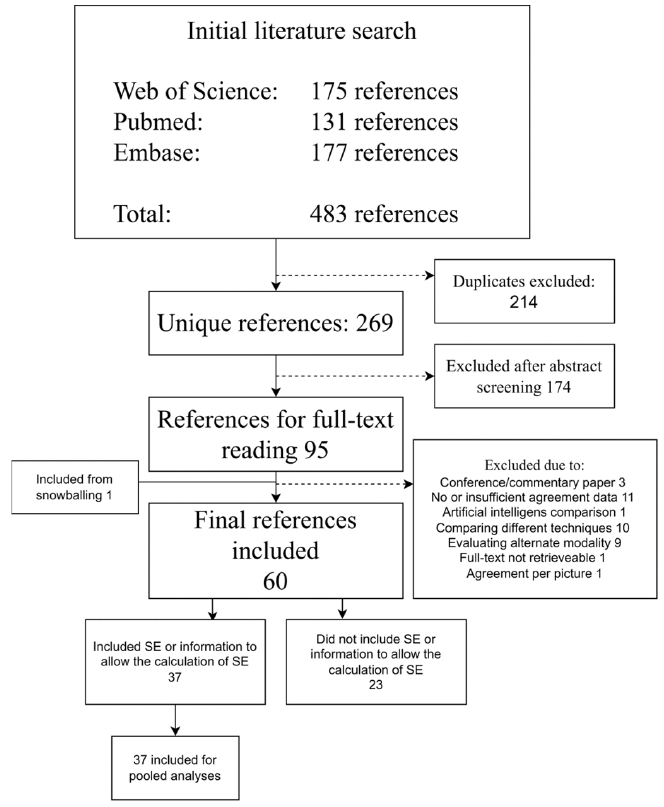
Figure 1. Flow diagram of the study. Abbreviations: SE, standard error. Table 2. Characteristics of included studies, including methodological quality assessment.